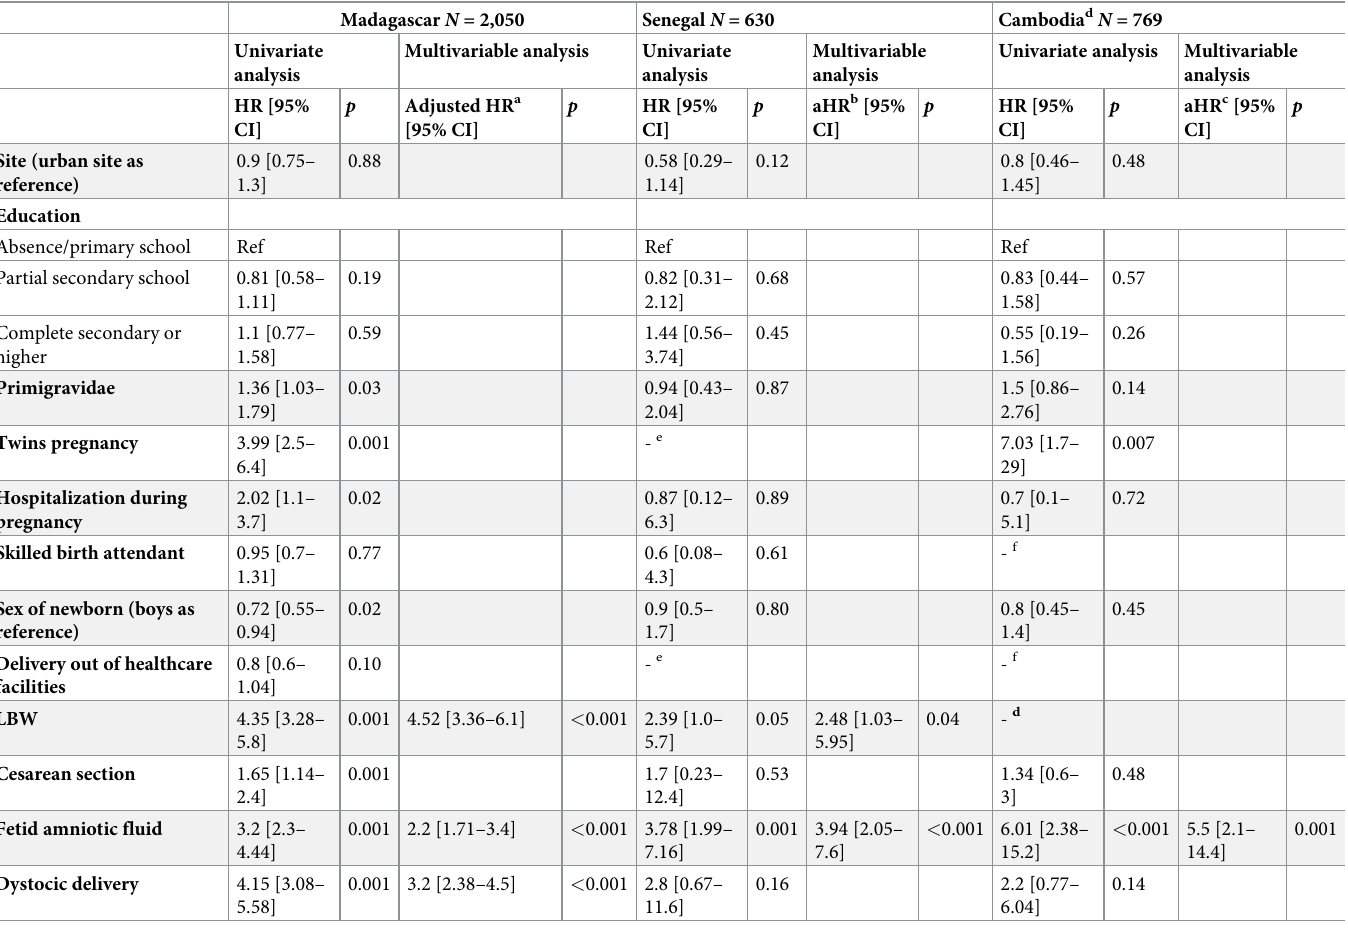
Table 2. Risk factors analysis of possible severe bacterial neonatal